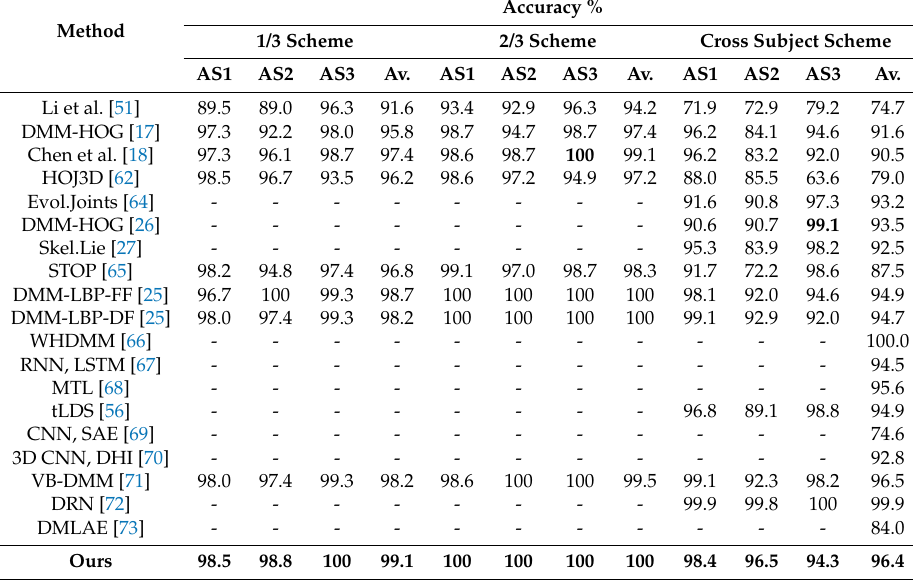
Table 11. Performance of the proposed method compared to the state-of-the-art approaches in terms of the MSR action 3D dataset